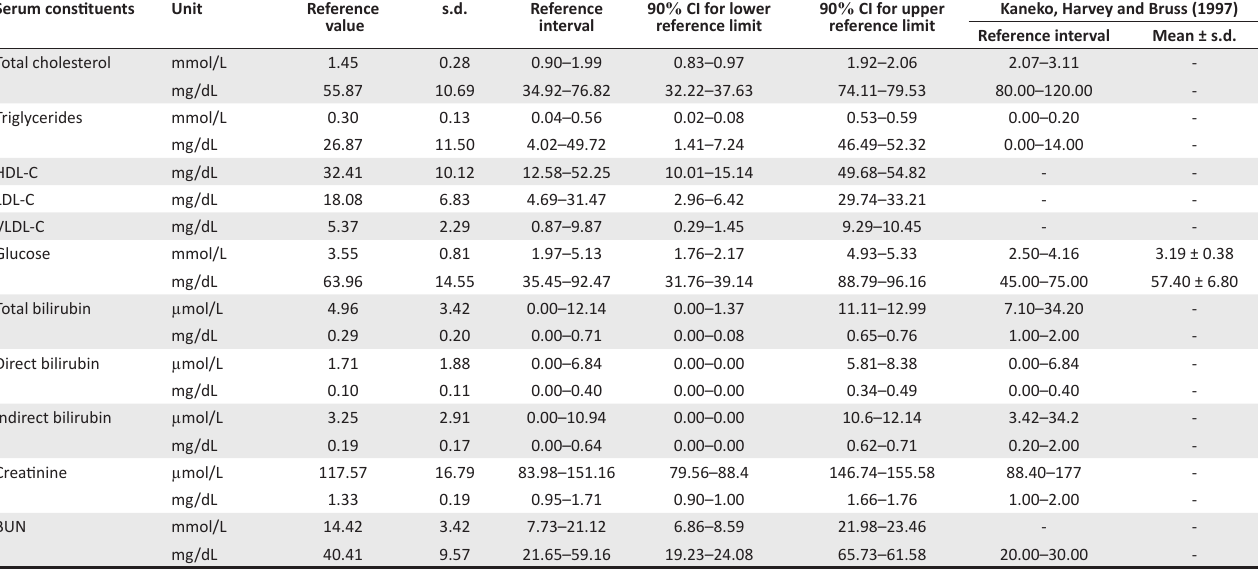
TABLE 4: Reference intervals for serum constituents in buffalo heifers. Serum